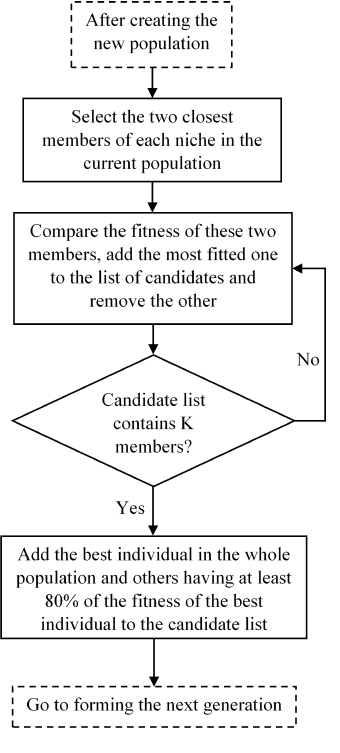
Figure 4: Preparing candidate list at the end of inner loop of “loop in